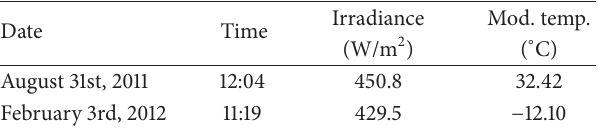
Table3:EnvironmentalconditionsofthePVmoduleequippedwith radiation and temperature sensors S19 at the moments, when curves in Figure 11 were